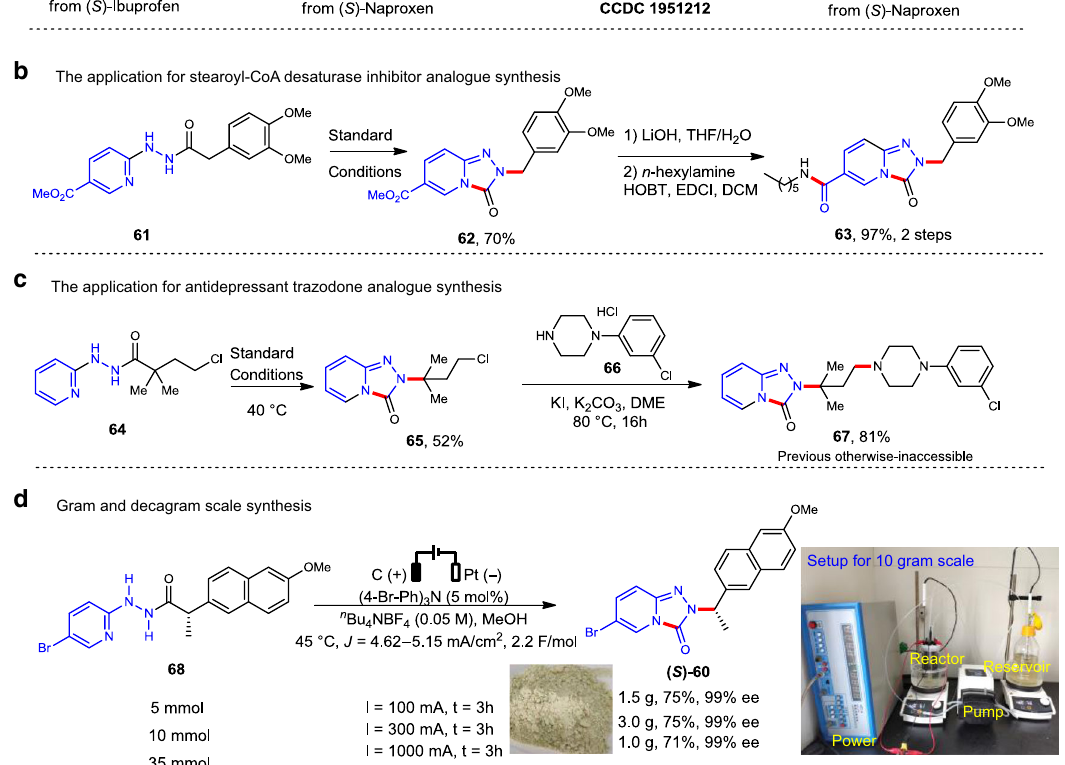
Fig. 3 Synthetic applications of this electrochemical rearrangement. a Synthesis of chiral triazolopyridinone derivatives. b Synthesis of stearoyl-CoA desaturase inhibitor analog. c Synthesis of antidepressant drug trazodone analog. d Large scale